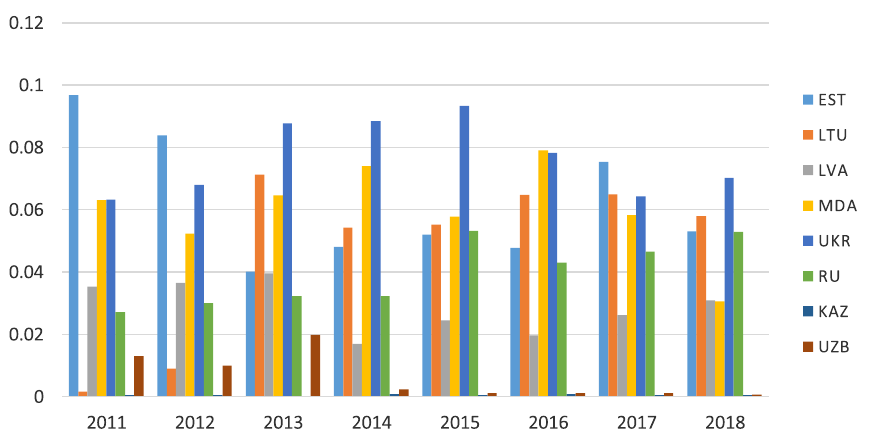
Figure 6. Charges for the use of intellectual property, receipts (% of GDP) in post-Soviet countries in